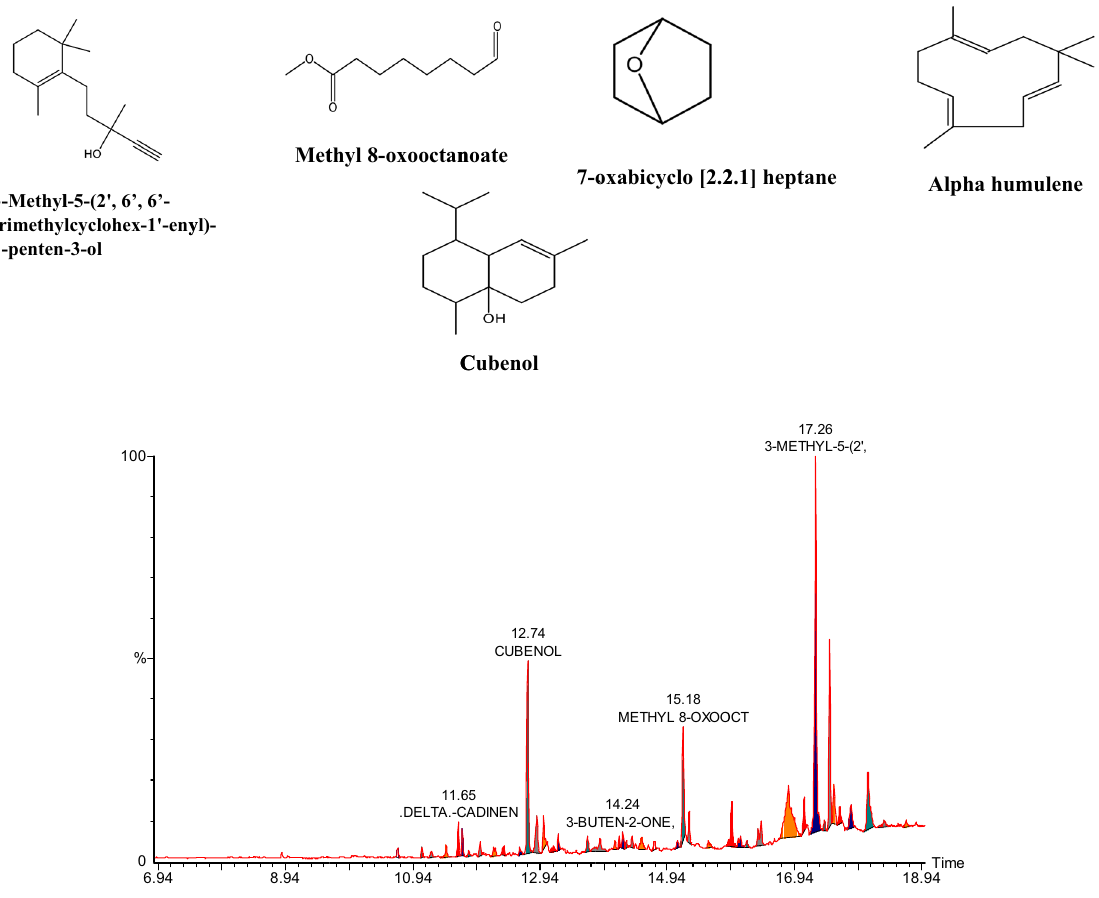
Figure 4: GC - MS chromatogram and chemical structures of some constituents from JPCF.